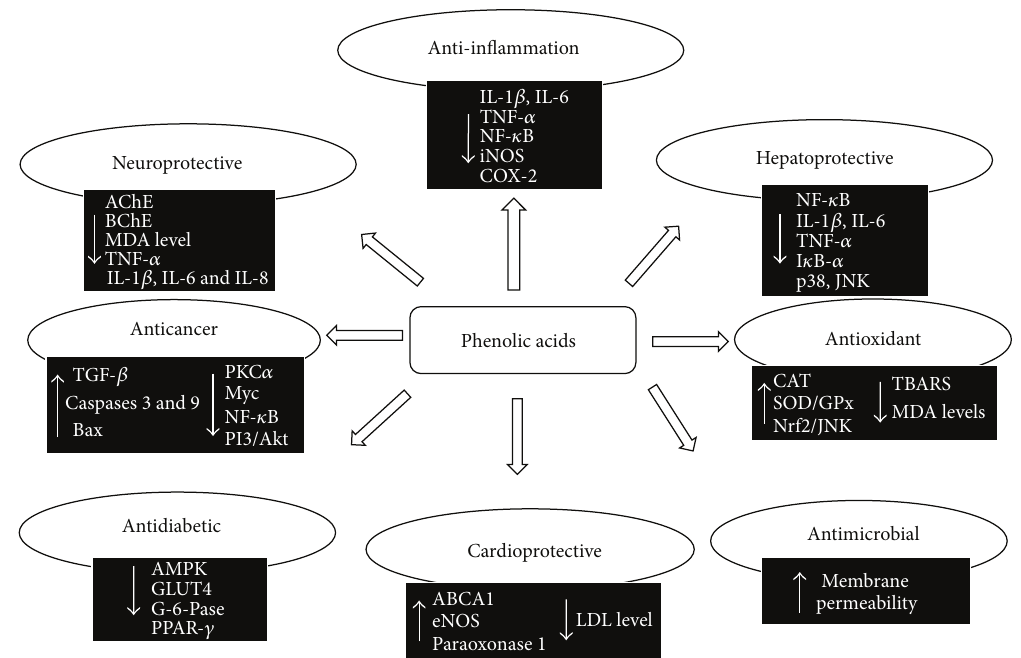
Figure 1: Key factors involved in health beneficial effects of natural